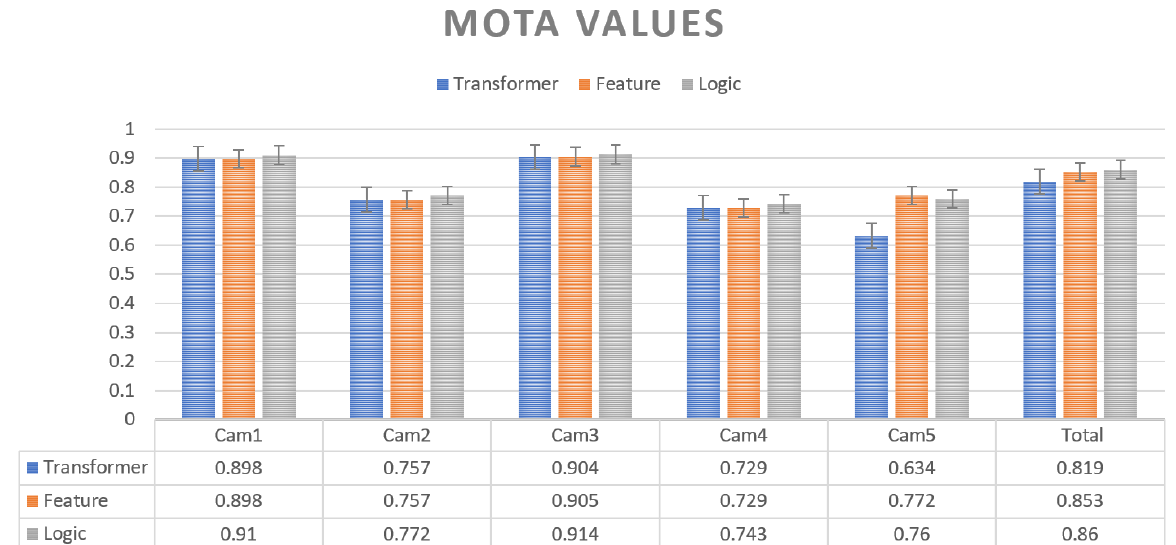
Figure 10. OVIT-MOT01 MOTA values for each camera.